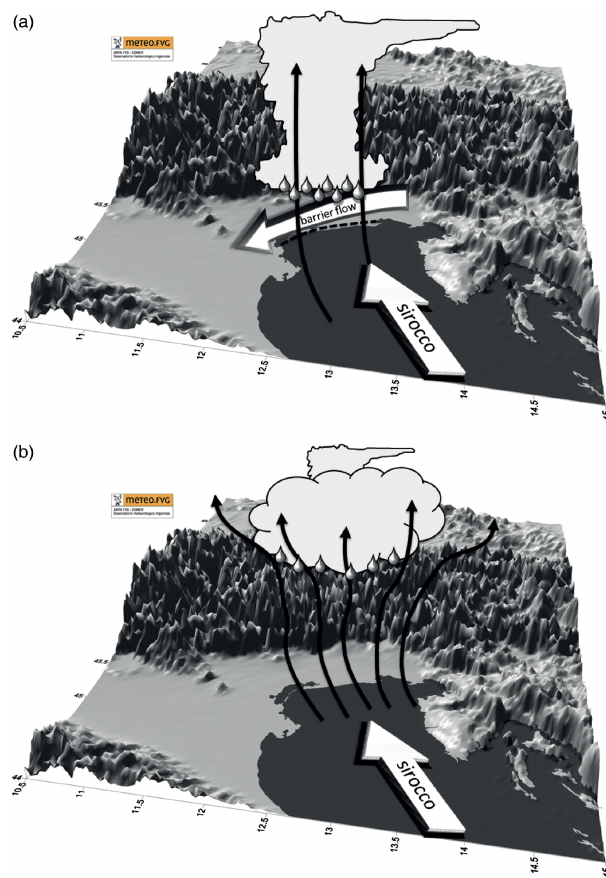
Figure 3. Schematic diagram of the key mechanisms responsi- ble for the two different precipitation patterns over NEI. (a) Up- stream event: blocked low-level flow, barrier wind, convergence and deep convection development occurring over the plain, upstream of the orography. (b) Alpine event: unblocked low-level flow, flow- over conditions, orographic lifting, and precipitation over the Alps with possible embedded convection (from Davolio et al.,